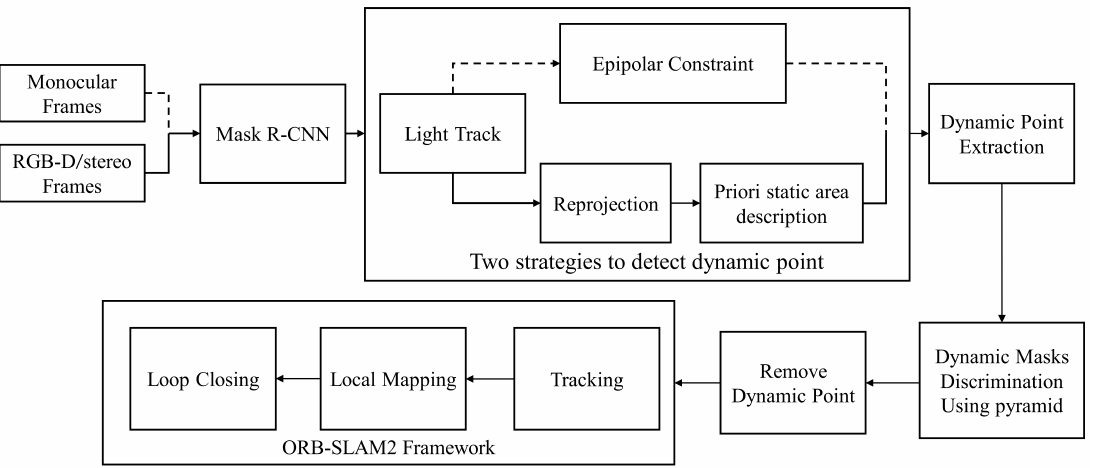
Figure 3. Detailed framework of our proposed method. We add a front-end stage to the ORB-SLAM2 framework as illustrated in the figure. A low-cost tracking algorithm is needed to calculate the initial ego-motion after the Mask R-CNN module. Then, there are two different strategies to extract dynamic feature points for monocular and RGB-D/stereo cases. We discriminate which masks are dynamic so that all feature points in the corresponding dynamic content can be